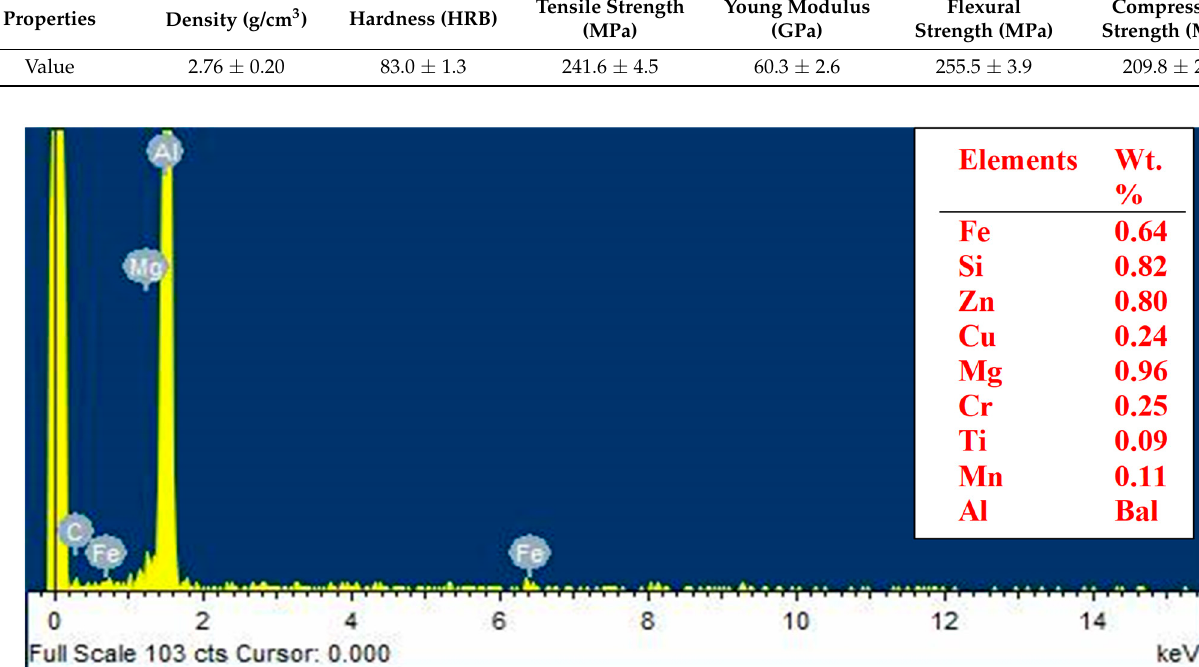
Figure 1. Elemental composition of Al6061 according to EDS measurement.